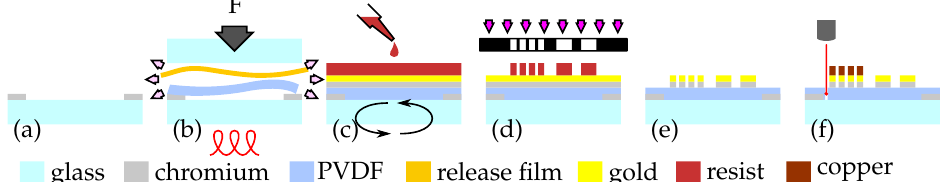
Figure 3. Smart inlay micro fabrication process: ( a ) Sputtering chromium ring with shadow mask. ( b ) Fixing PVDF substrate to the carrier wafer under vacuum and heat. ( c ) Sputtering the chromium gold layer and applying photoresist. ( d ) Transferring pattern by n-tone lithography. ( e ) Etching of metallic layers and removing resist. ( f ) Electroplating wires and laser cutting.